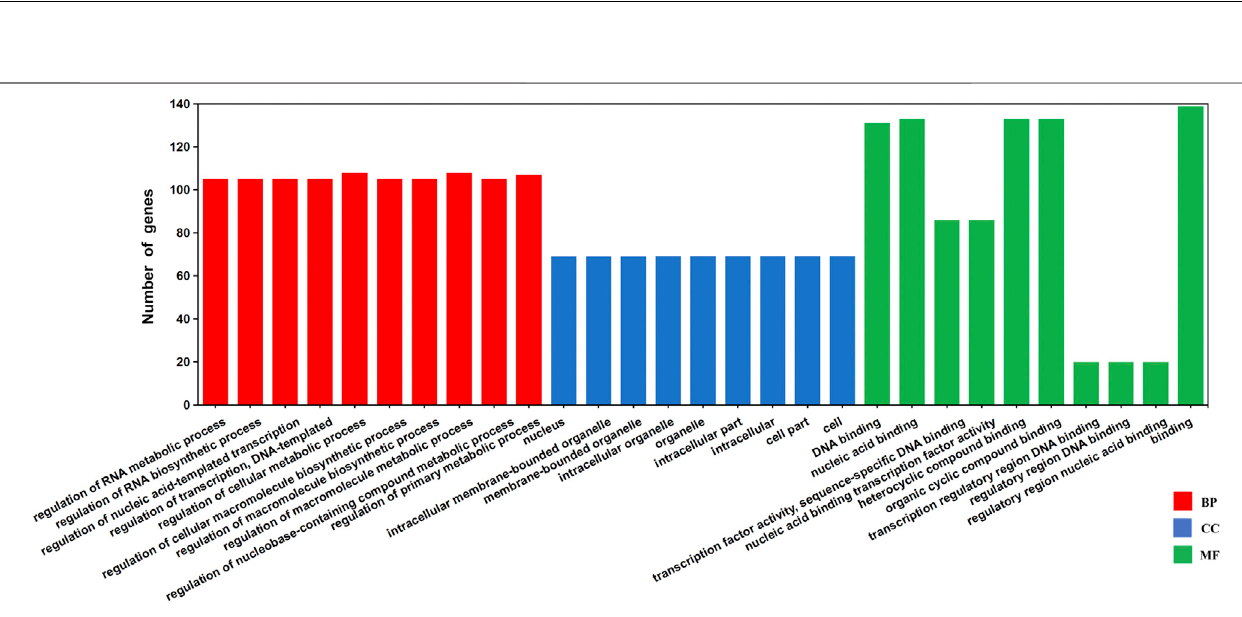
FIGURE 5 | Gene Ontology (GO) annotation of the TFs binding to the putative upstream sequences of GhJMJs based on their cellular component, molecular function, and biological process. The Y-axis represents the number of genes in a sub-category. BP: Biological Process, CC: Cellular Component, MF: Molecular